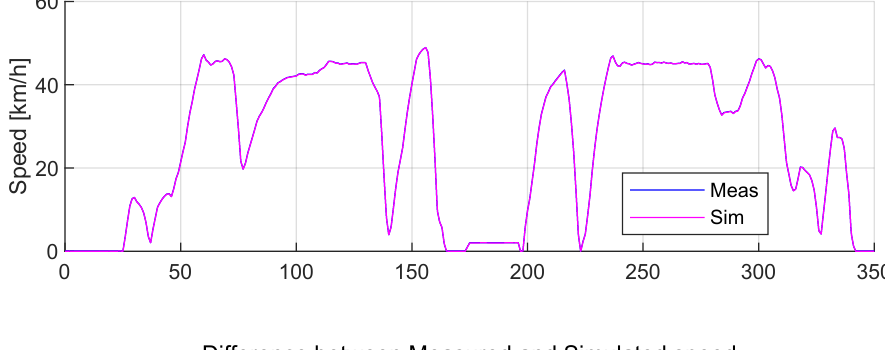
Difference between Measured and Simulated speed